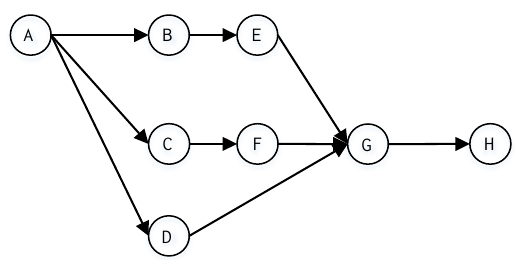
Figure 2. An example of precedence diagram.